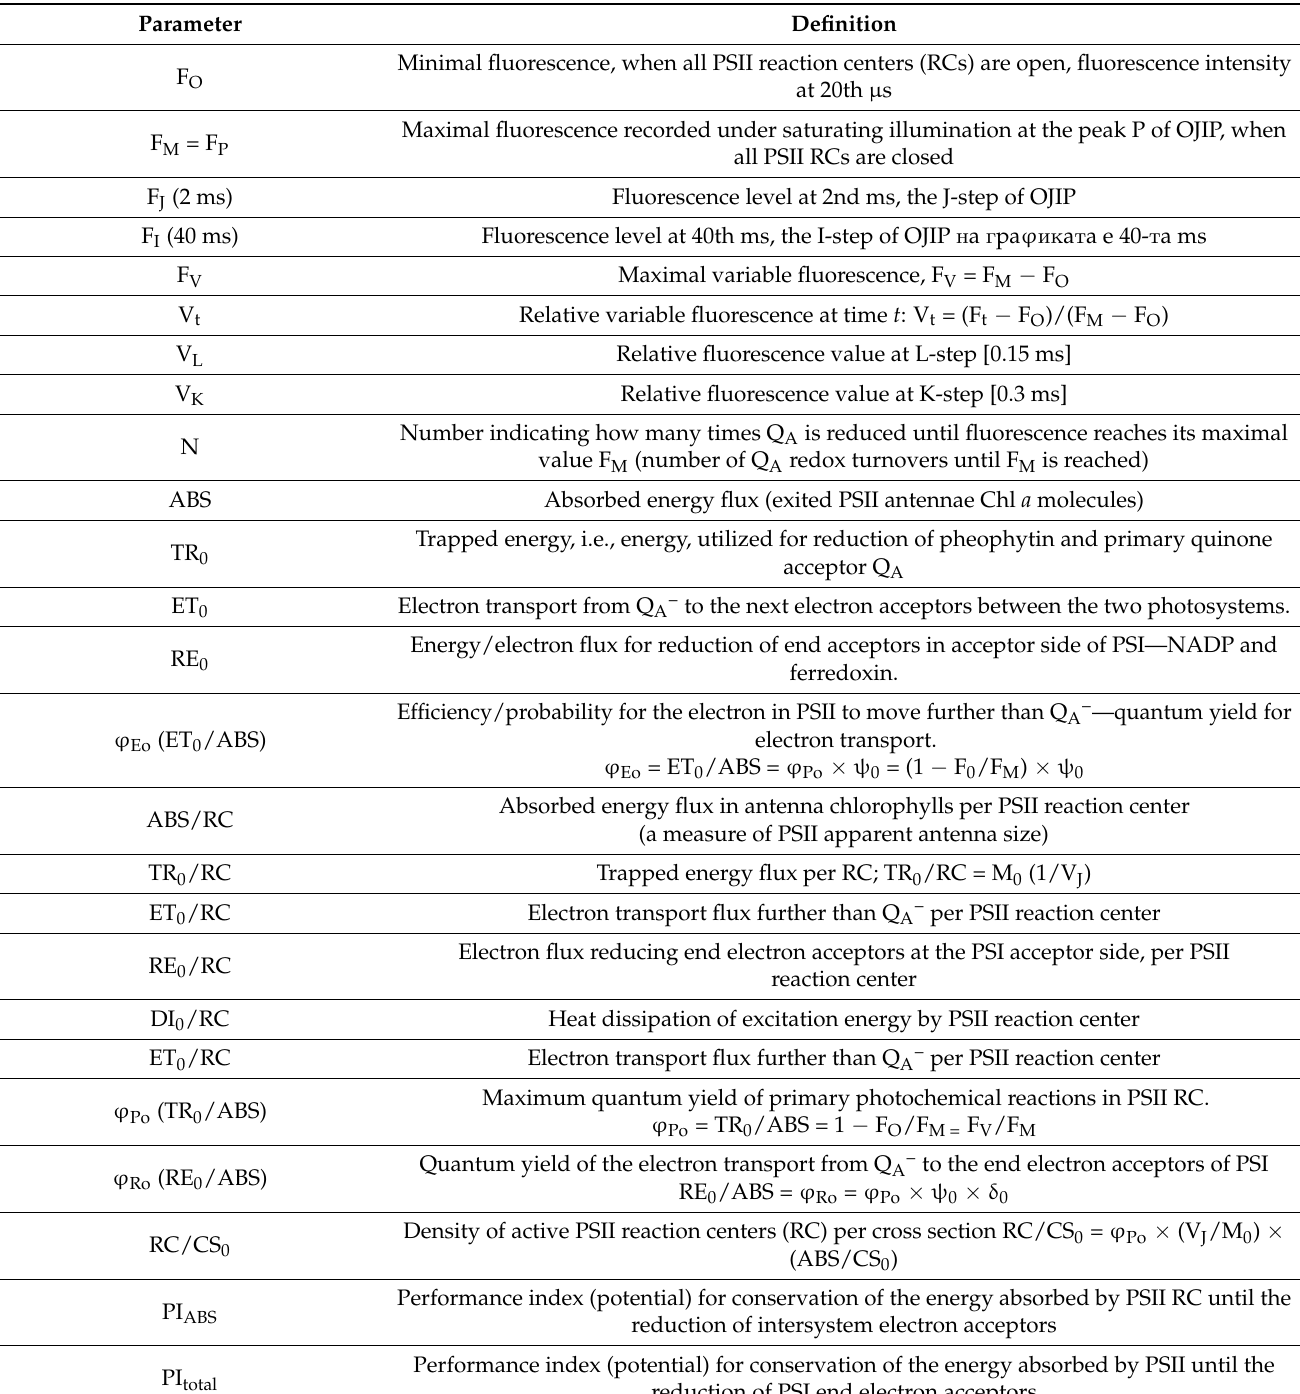
Table A1. Definition of selected OJIP parameters according to Strasser et al. [14] and Stirbet and Govindjee [15].